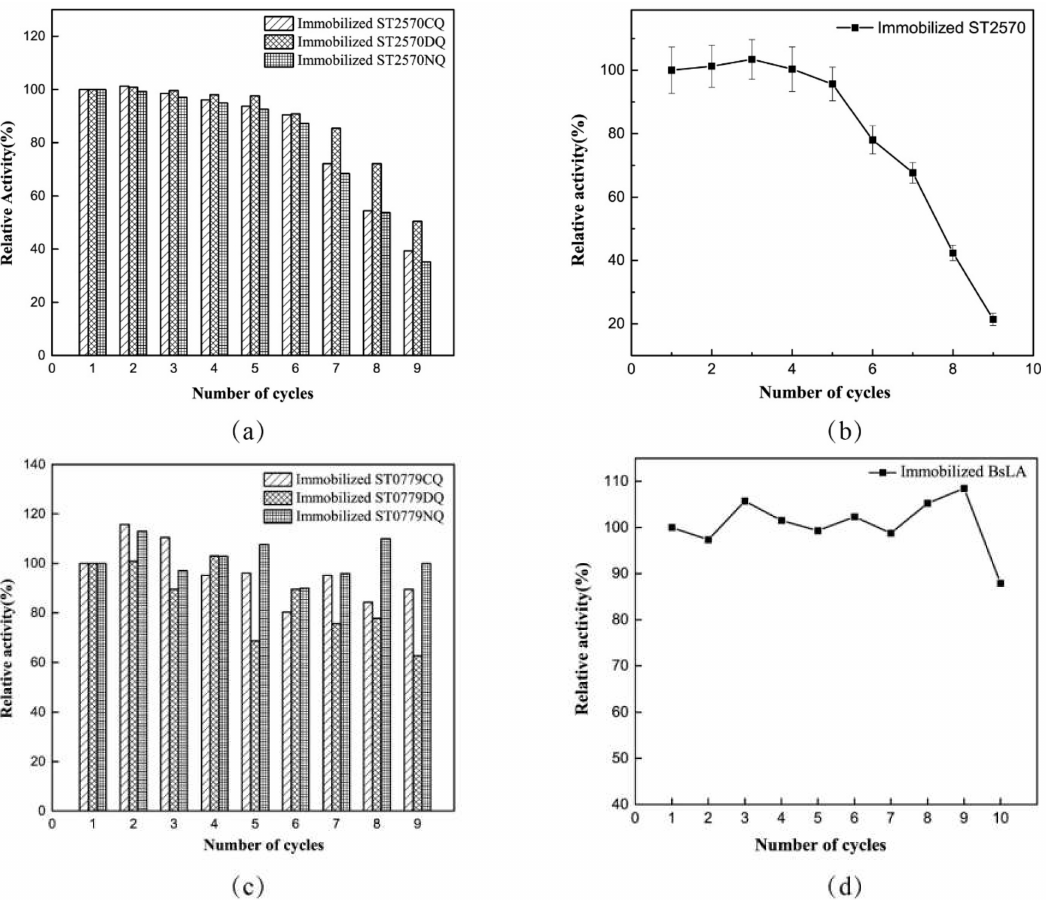
Figure 5. The reutilization of the immobilized enzyme. ( a ) The number of reuses of ST2570 immobilized by resin D380; ( b ) the number of reuses of ST2570 immobilized by SBA-15 [28]; ( c ) the number of reuses of ST0779 immobilized by Fe 3 O 4 covered with SiO2; ( d ) the number of reuses of BsLA immobilized by Fe 3 O 4 covered with SiO 2